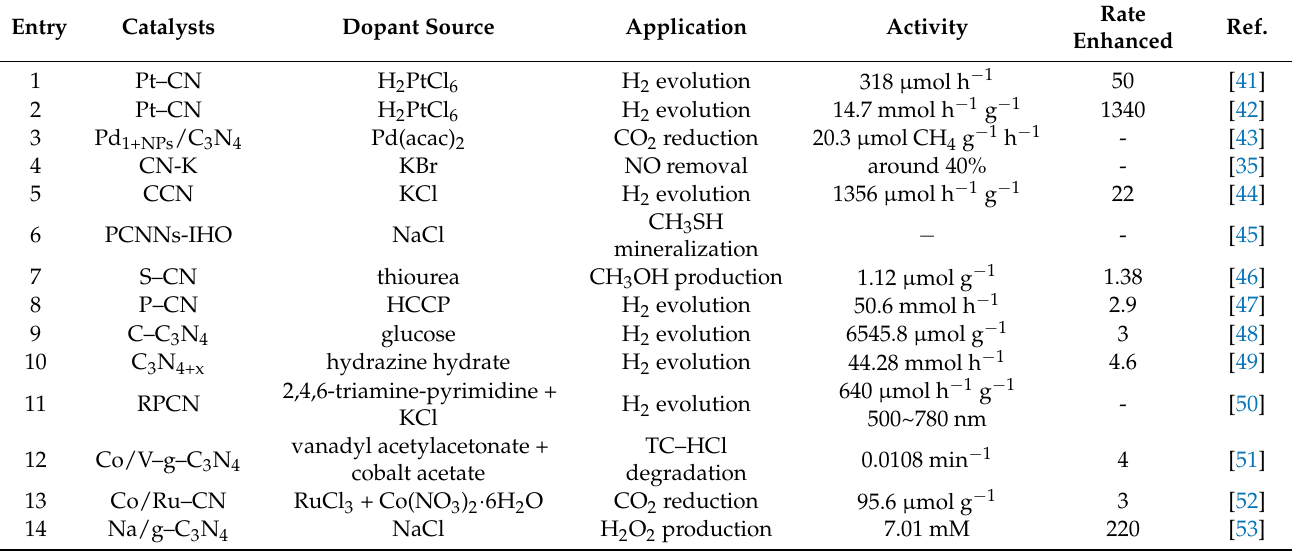
Table 1. Summary of the photocatalytic activity of modified